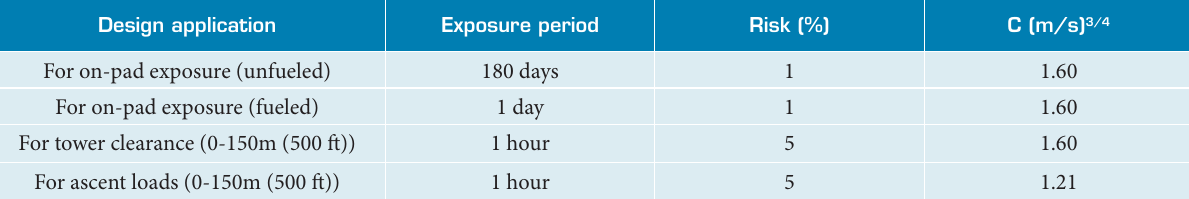
Table 3. Surface wind criteria to use for certain ground mission